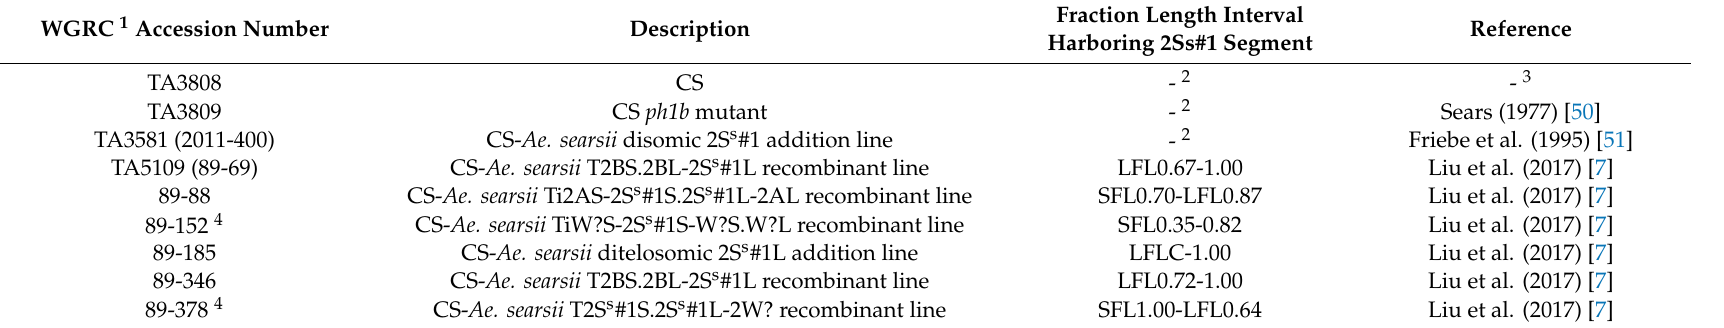
Table 1. List of plant materials used in this